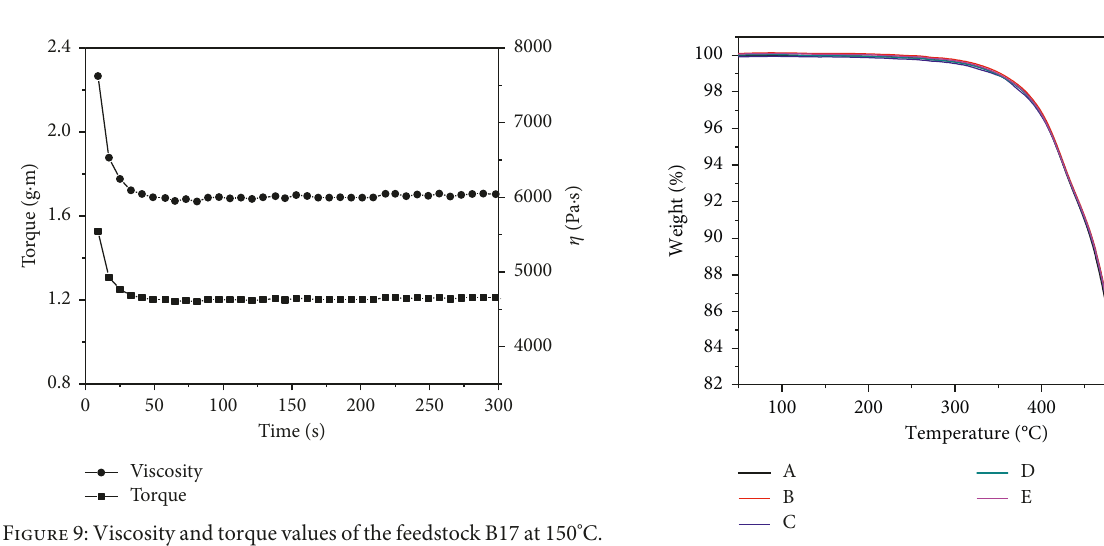
Figure 10: TGA curves of 5 crude